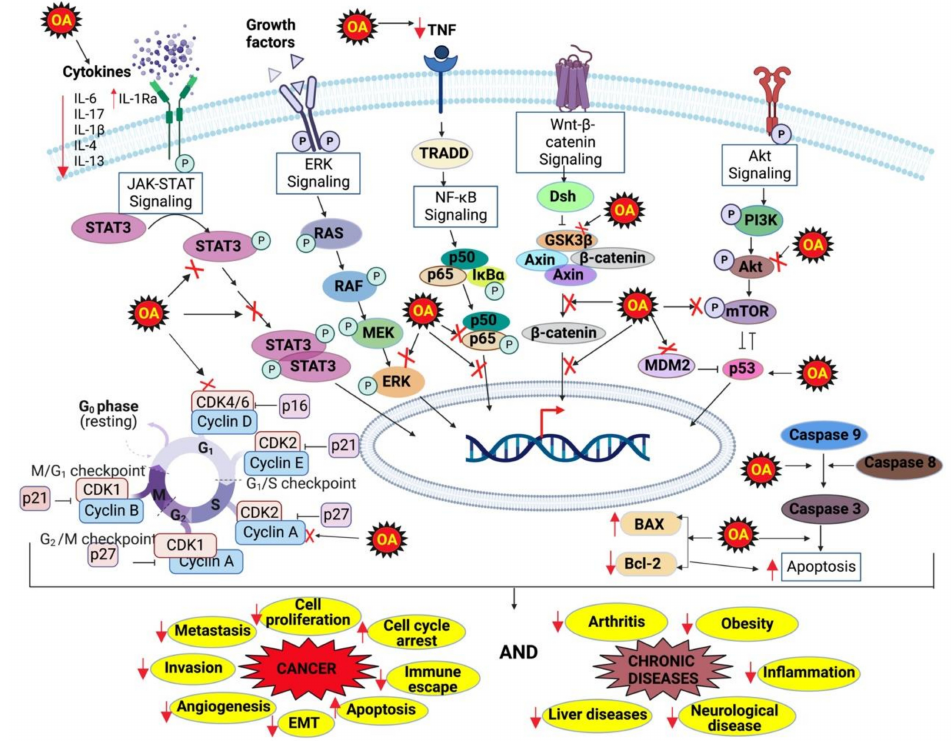
Figure 2. Mechanisms of action of OA against various chronic